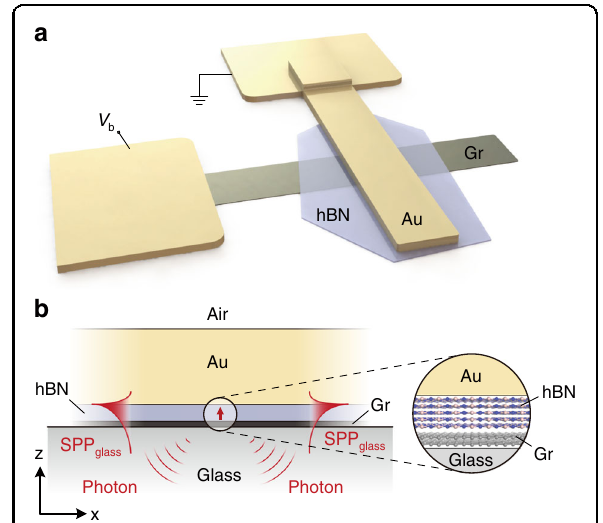
Fig. 1 Device schematic. a Schematic illustration of the biased Au// hBN//Gr tunneling junction. b Cross-section of the junction area with a red-upward arrow representing the dipole. Direct excitation of the SPPs (SPP glass ) and photons are schematically shown. The zoom-in area illustrates the layered nature of the hBN and few-layer